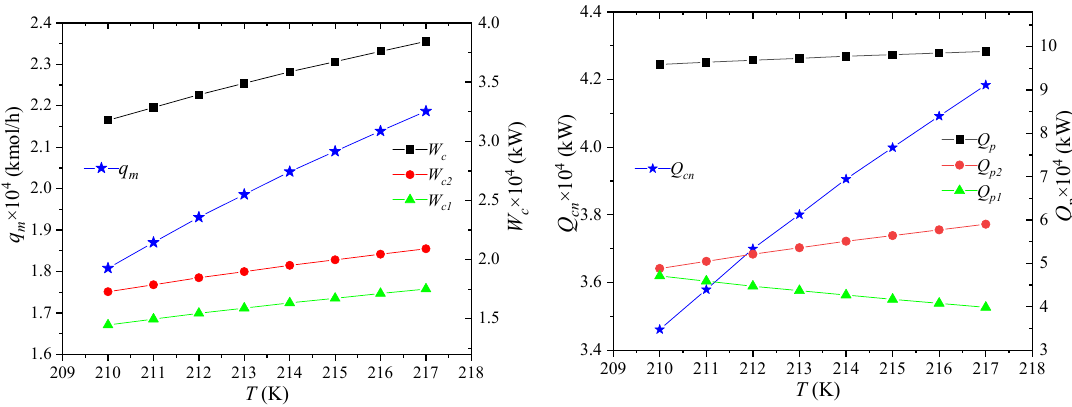
Figure 5. E ff ects of NG temperature on process performance.